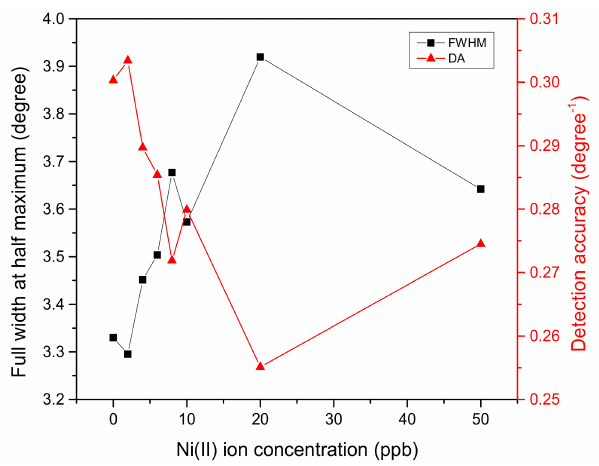
Figure 6. Full width at half maximum and detection accuracy of Au/MPA/V–CNCs–CTA thin film when detecting Ni(II) ion solution ranged from 2 ppb to 50